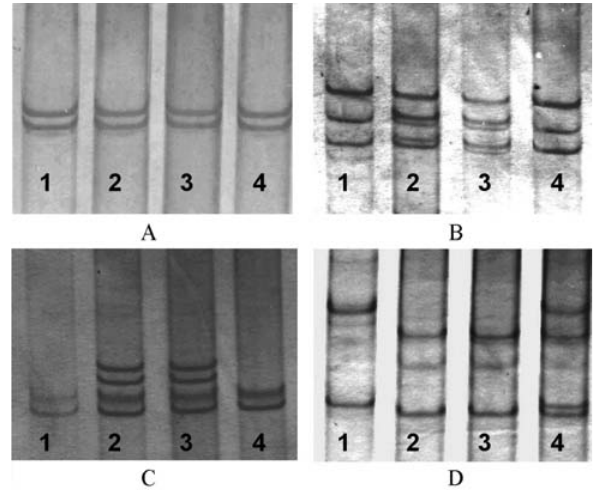
Figure 1 - Polyacrylamide gels showing amplified products of the human butyrylcholinesterase BCHE gene. A: absence of variability in exon 3. B: exon 2 ( G390V region) - U/U (1, 4); U/G390V (2, 3). C: exon 2 ( D70G re- gion) - U/U (1, 4); U/D70G (2, 3). D: exon 4 - A539T/A539T (1); U/U (2, 3); U/A539T